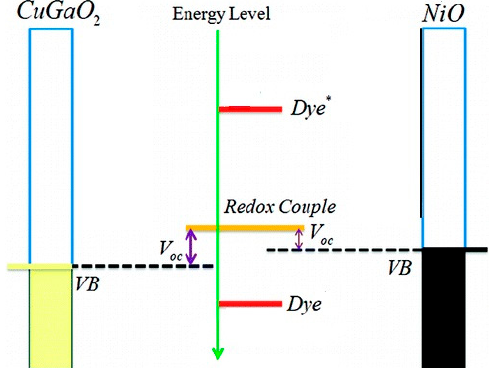
Table 1. Characteristic parameters of the p ‐ DSCs differing for the nature of the nanostructured photocathode and dye ‐ sensitizer. Redox shuttle: I 3 − /I − in acetonitrile.